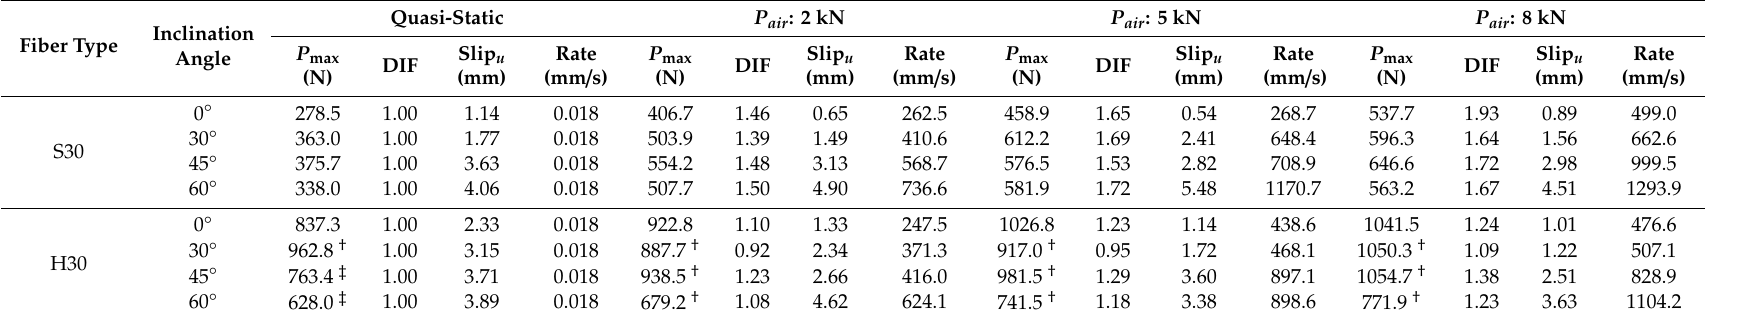
Table 4. Summary of maximum pullout load and slip capacity of S- and hooked (H)-fibers at various loading